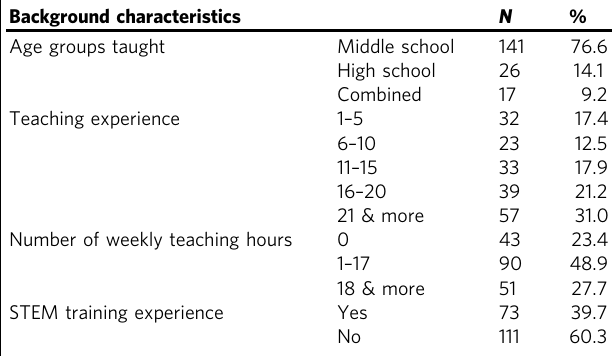
Table 2 Background characteristics analysis ( N =